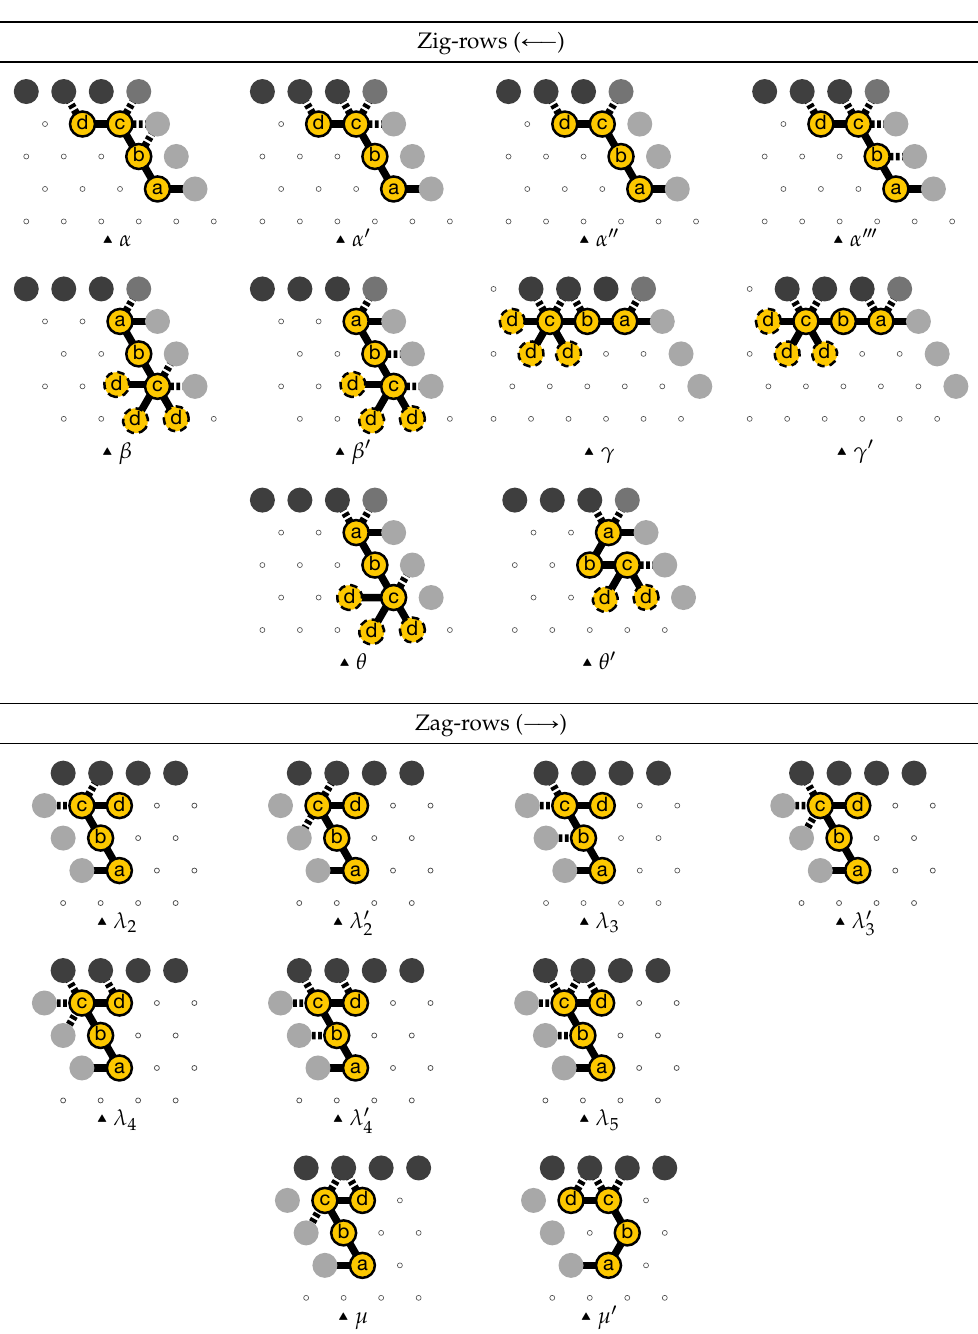
Figure 17. Notation for the various possible sets of output nascent